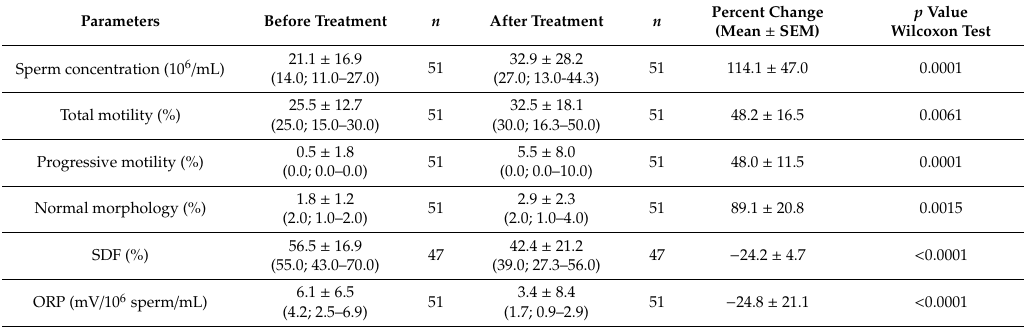
Table 4. Summary statistics of semen parameters, SDF, and ORP before and after the treatment with FH PRO for Men in idiopathic infertile patients having high SDF levels.